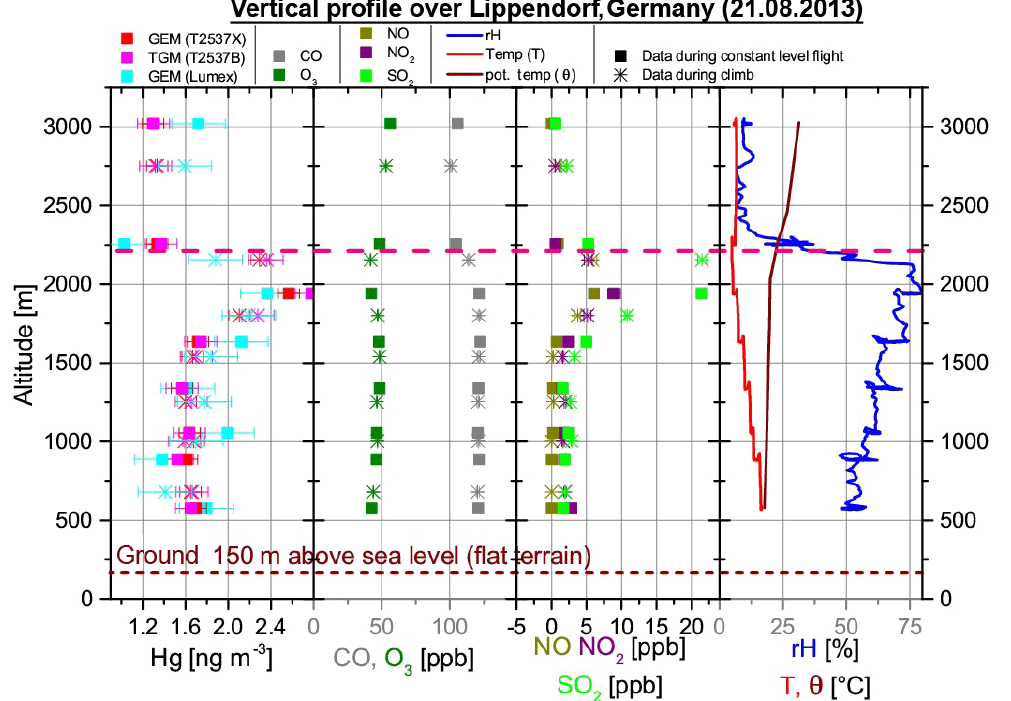
Figure 6. Vertical profile, measured on 21 August 2013 from 13:17:30 to 14:07:30 (local time) downwind from the coal-fired power plant, Lippendorf (central Germany; 45.561 ◦ N, 14.858 ◦ E; elevation: 150ma.s.l.; flat terrain). Squares represent 300s averages with horizontal flight leg and stars indicate 150s averages during climbing between two neighboring flight legs. The red dashed line indicates the planetary boundary layer (PBL) top, which was determined to be at 2150 to 2250ma.s.l. All Hg concentrations are given at standard temperature and pressure (STP; T = 273.15K, p =